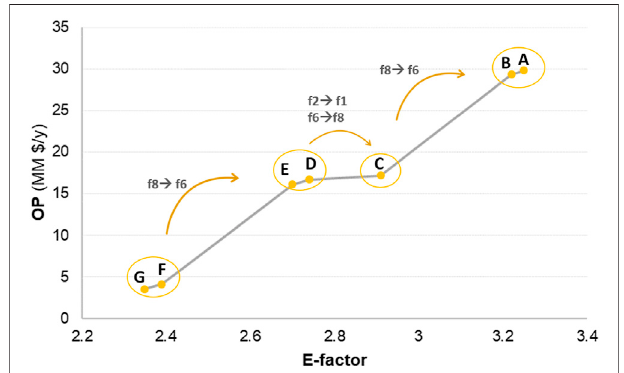
FIGURE6| Paretofrontofsolutions:OPvs.E-factor.Extremesolutions: Solution A and Solution G.